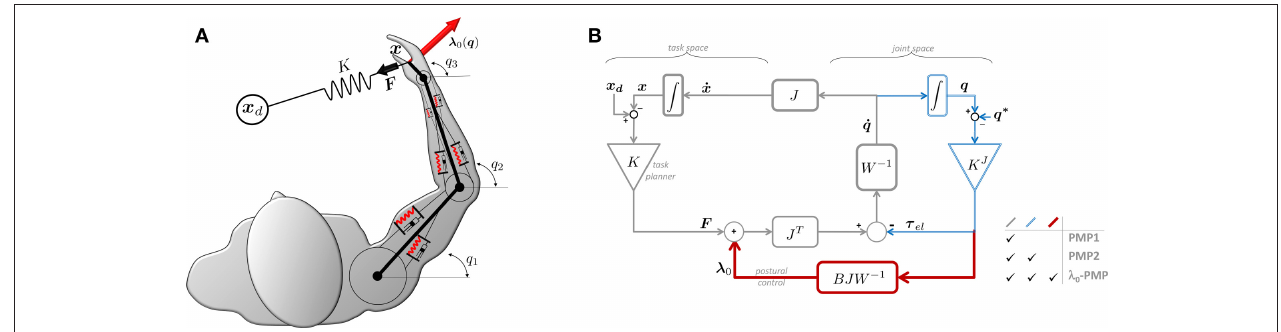
FIGURE 1 | λ 0 -PMP as an extension of the Passive Motion Paradigm. (A) Example of a 3DOF human-like arm performing a redundant 2D reaching task. (B) Block diagram of the general λ 0 -PMP